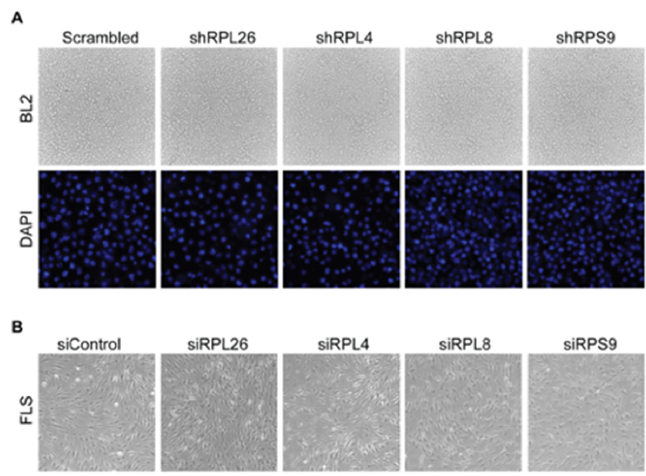
Figure A2. ( A ) Microscopy (upper) and DAPI staining (lower) showing no obvious di ff erence on cell morphology between the scrambled shRNA BL2 cells and BL2 cells with shRNA knockdown of RPL26, RPL4, RPL8 and RPS9 . ( B ) Microscopy showing no obvious di ff erence on cell morphology between the scrambled shRNA FLS and FLS with siRNA knockdown of RPL26, RPL4, RPL8 and RPS9